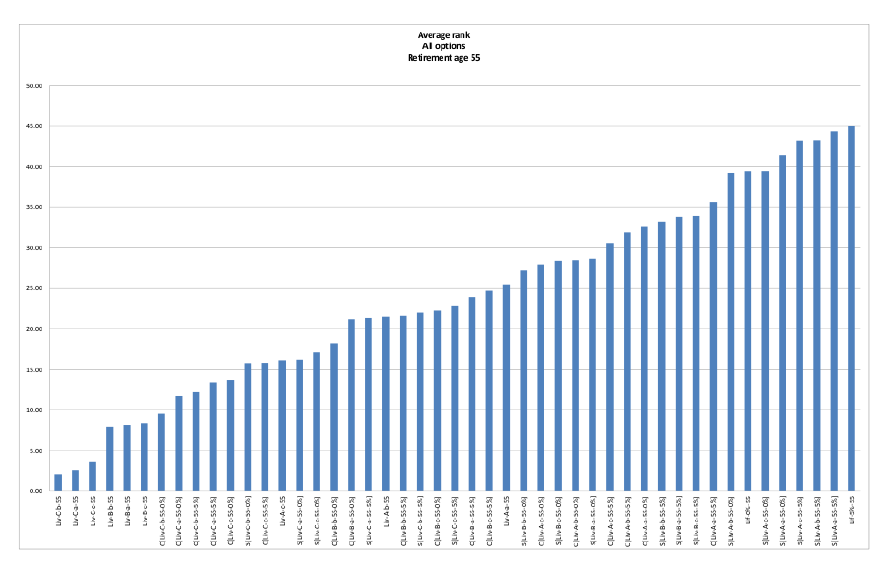
FIGURE 1: Average rank for all annuity strategies for a male retiree aged 55 Source: Authors,